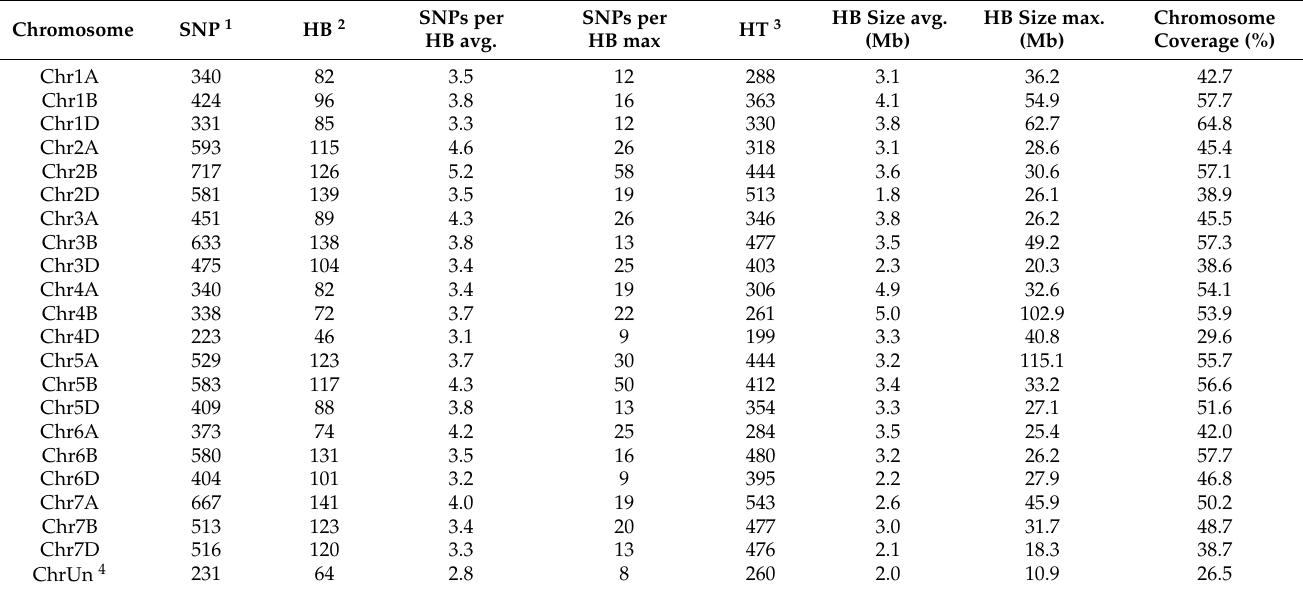
1 single nucleotide polymorphism; 2 haploblock; 3 haplotype; 4 chromosome unknown. On average, the number of SNP markers per HB ranged from 3.1 on chromosome 4D to 5.2 on chromosome 2B, while the maximum was 58 SNPs (chromosome 2B). The mean HB ranged from 1.8–3.8 Mb on genome D to 2.6–4.9 Mb on genome A. The largest one was constructed on chromosome 5A (115.1 Mb). The mean chromosome coverage reached 50.1% on genome B and a little less on genomes A and D (49.8 and 49.1, respectively). Visualization of HBs and HTs located within Fhb1 flanking markers is shown in Figure